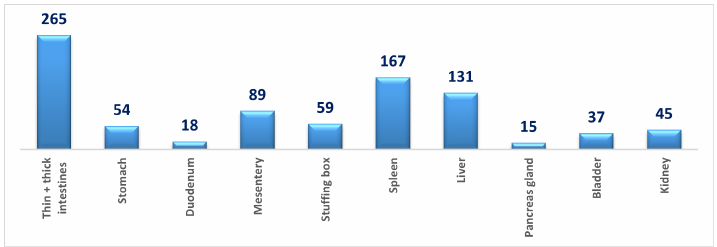
Figure 13. Damage to the abdominal organs and retroperitoneal space with concomitant injury